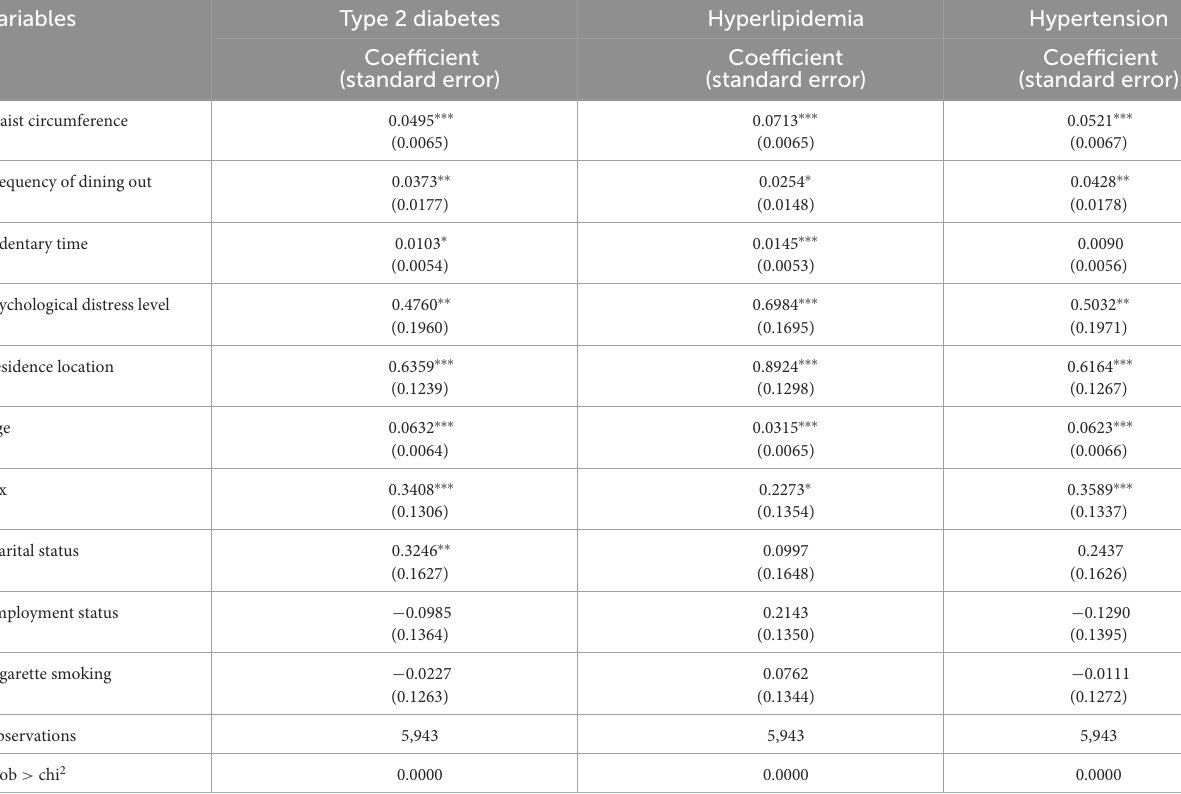
TABLE 4 Robustness check supporting baseline results using the method of key variable replacement. Variables